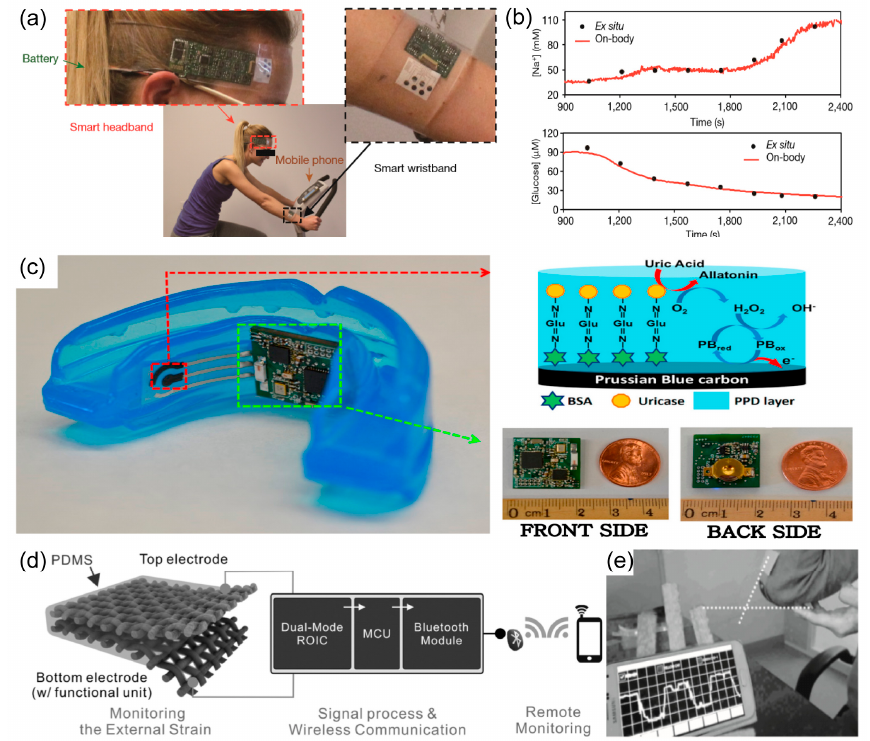
Figure 9. Bluetooth integrated wearable sensors. ( a ) Photographs of wearing a wearable sensor in band types during a stationary cycling; ( b ) Real-time reading data of the sodium and glucose measured